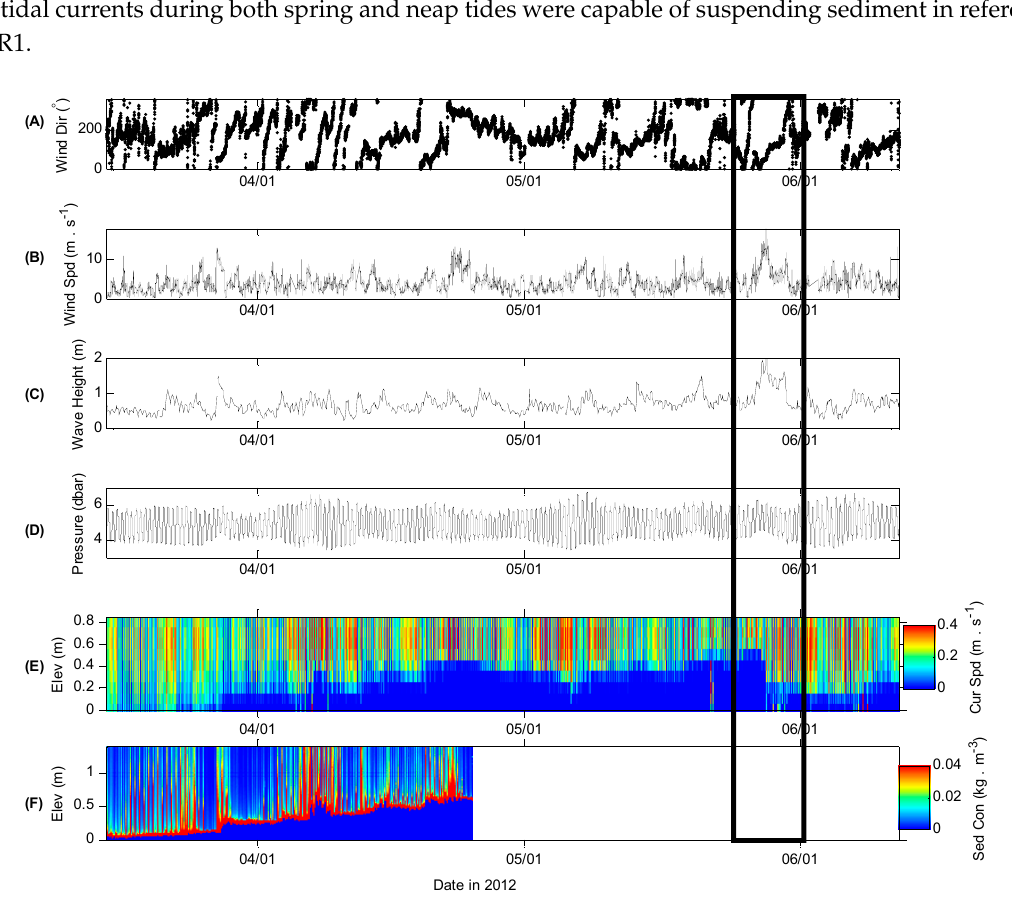
Figure 2. ( A ) Wind direction and ( B ) speed from Fort Pulaski, GA; panels ( C – F ) are data from R1 site collected between March 15 and June 12, 2012. ( C ) Wave height and ( D ) pressure are based on an upward-looking acoustic wave and current profiler (AWAC). ( E ) Current speed is from the pulse-coherent acoustic Doppler current profiler (PCADP). ( F ) Suspended sediment concentration is from a downward-looking acoustic backscatter sensor (ABS). The rectangle highlights the passing of Tropical Storm Beryl in late May 2012.